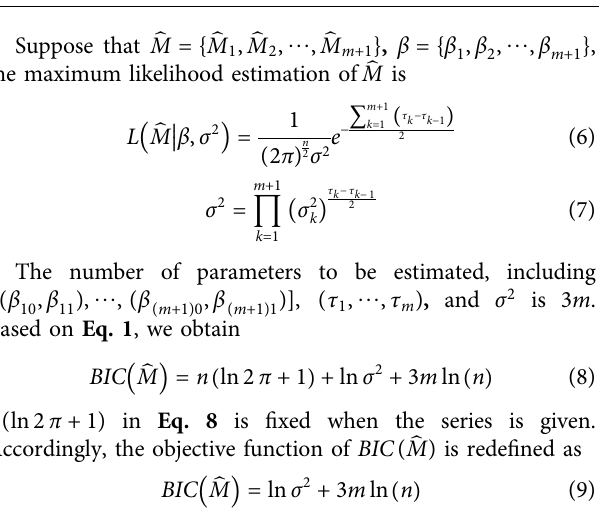
FIGURE 3 | Pseudo code for the adaptive thresholding